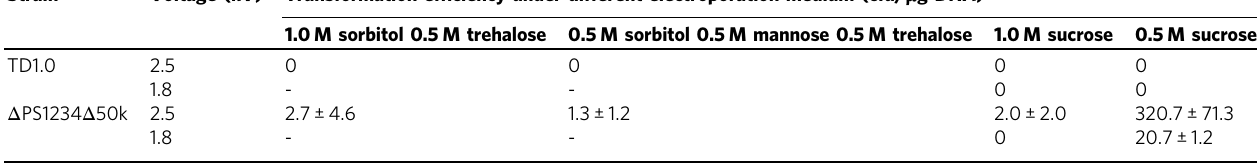
Table 1 Electrotransformation ef fi ciency of TD1.0 and Δ PS1234 Δ 50k under different electroporation media and voltages. Strain